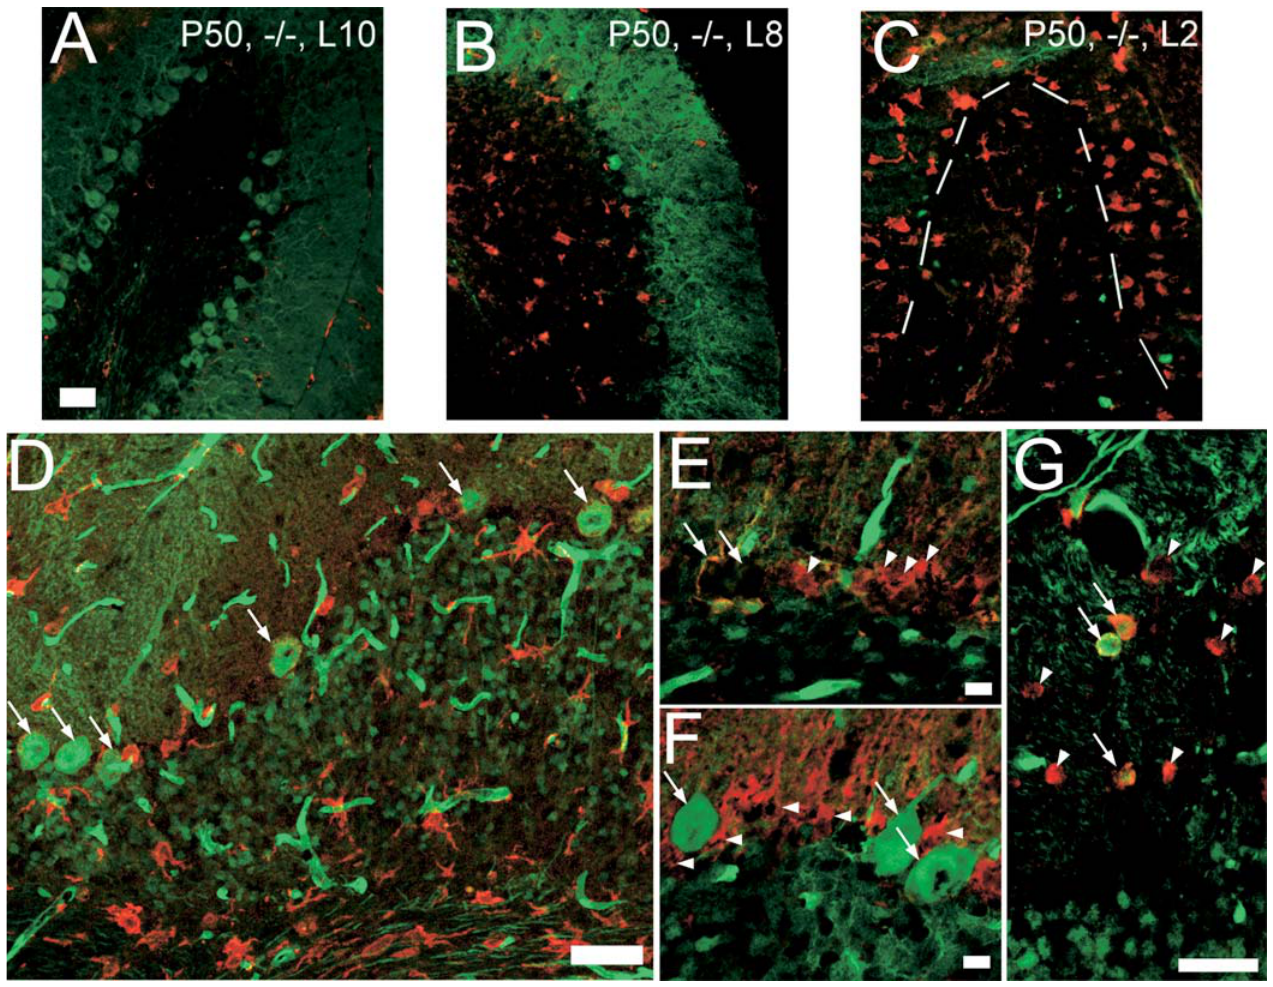
Figure 4. Other Histological Characteristics in the npc1 Mutant and Chimeric Mice (A–C) Microglia characteristics. Sections from 50-d-old npc1 mutants were stained with anti-Calbindin (green) to visualize PCs and anti-F4/80 (red) to mark microglia. (A) Very few microglia are present in lobule X, where no PC degeneration has yet occurred. (B) Lobule VIII demonstrates an infiltration of microglia in the granule cell layer and white matter tract. (C) In lobule II, nearly all PCs are gone and numerous microglia are present throughout the cerebellum. The dashed line indicates the edge of the granule cell layer. (D) Microglia infiltration is not sufficient to induce PC degeneration. C1.4 demonstrates numerous microglia marked by anti-F4/80 (red) in all layers of the cerebellum, including immediately adjacent to wild-type (GFP-positive) PCs (arrows). Despite this close approximation, no loss of wild-type PCs was detected by cell counting. The GFP transgene is apparently poorly expressed in microglia, as all microglia appear GFP-negative regardless of their genotype. (E) Mutant PCs are lost even when surrounded by wild-type Bergmann glia. A stretch of the PC layer in C4.8 is shown where no npc1 (cid:1) / (cid:1) (GFP-positive) PCs remain despite the presence of numerous wild-type (GFP-negative) glia (arrowheads) marked by anti-S100 b (red). The space occupied by two wild- type PCs is indicated (arrows) with two npc1 (cid:1) / (cid:1) (GFP-positive) glia directly underneath. (F) Wild-type PCs do not degenerate even when surrounded by mutant Bergmann glia. Three wild-type PCs (GFP-positive; arrows) in C1.4 have not degenerated despite only mutant glia (arrowheads) being in the immediate vicinity. (G) Oligodendrocytes in chimeric mice are a mixture of wild-type and mutant cells. Oligodendrocyte cell bodies are stained with anti-CC1 (red). Wild- type (GFP-positive; arrows) and npc1 (cid:1) / (cid:1) (GFP-negative; arrowheads) oligodendrocytes are interspersed in C1.4. Bar ¼ 50 l m for (A), (D), and (G); 10 l m for (E) and